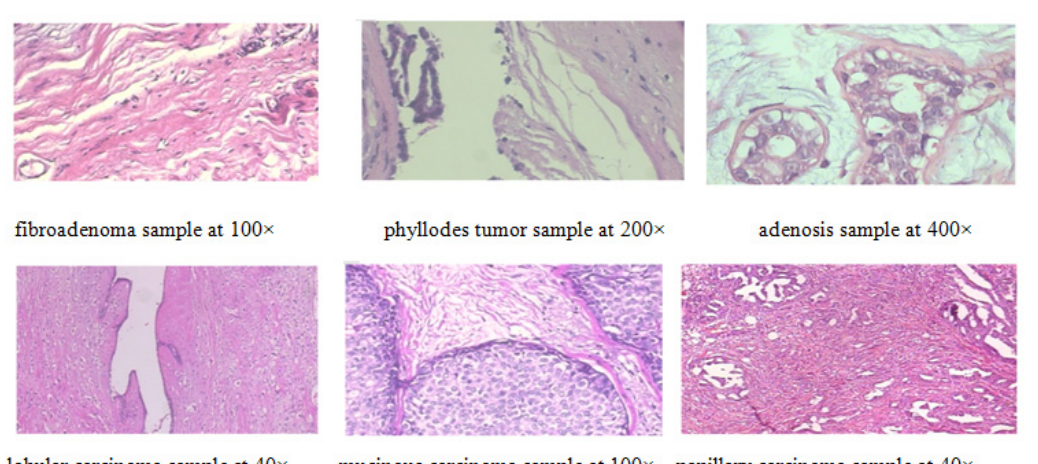
Figure 9. Random samples selected from BreakHis dataset.